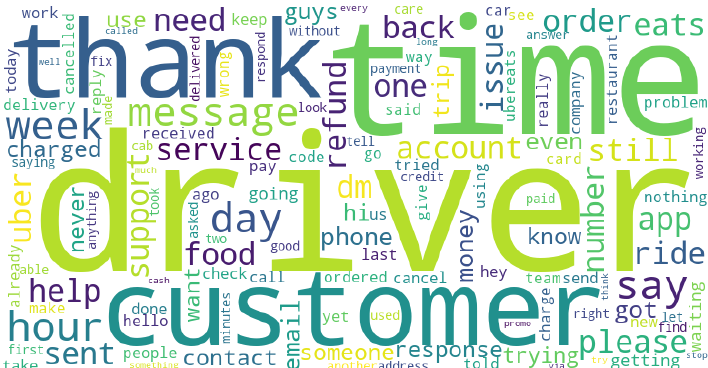
Figure 3. Most repeated words tweeted by